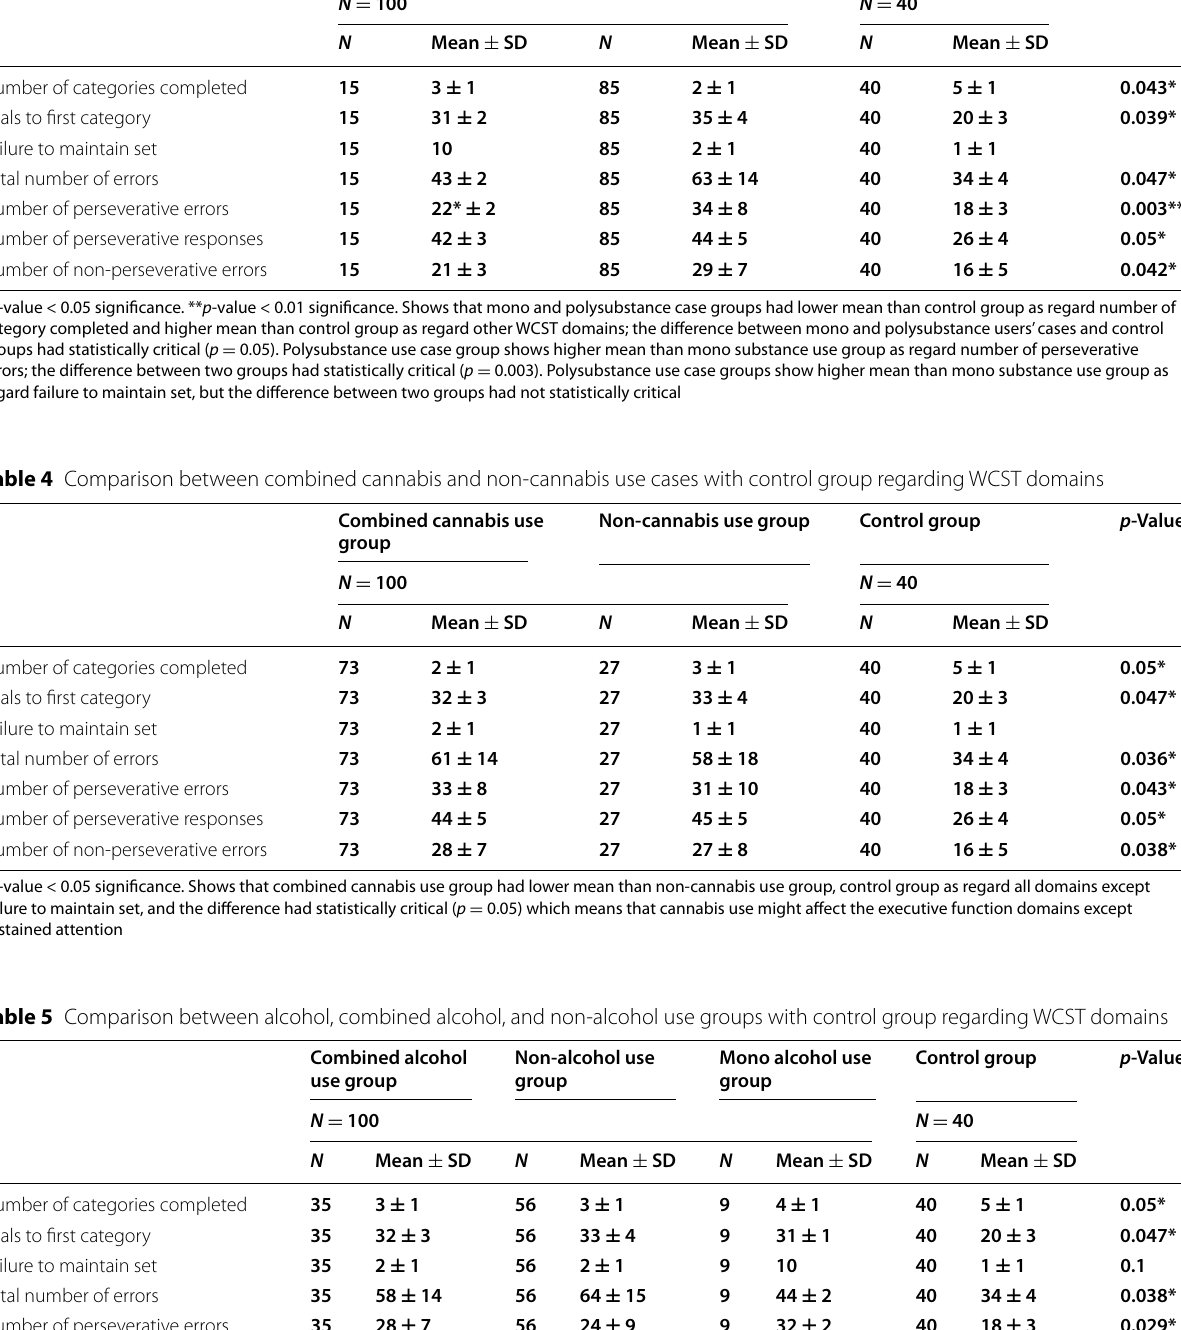
Table 3 Comparison between mono and polysubstance use groups with control group regarding WCST domains